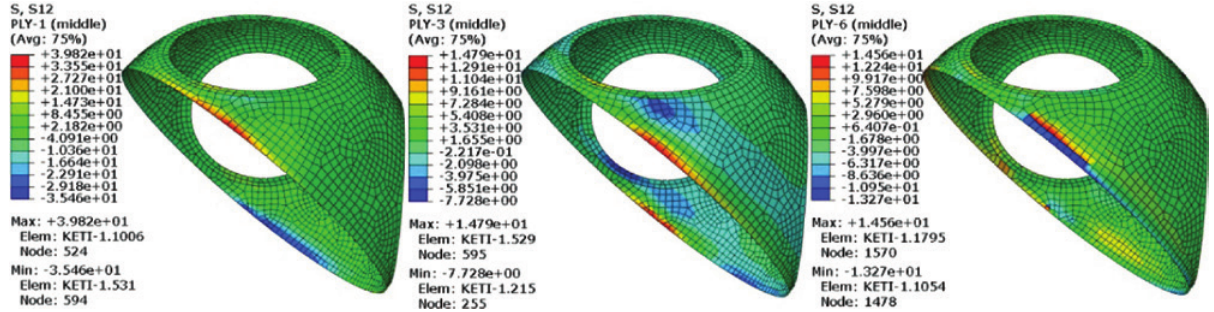
Figure 7: Stress nephogram of spherical shell’s first, third, and sixth layers (torque).